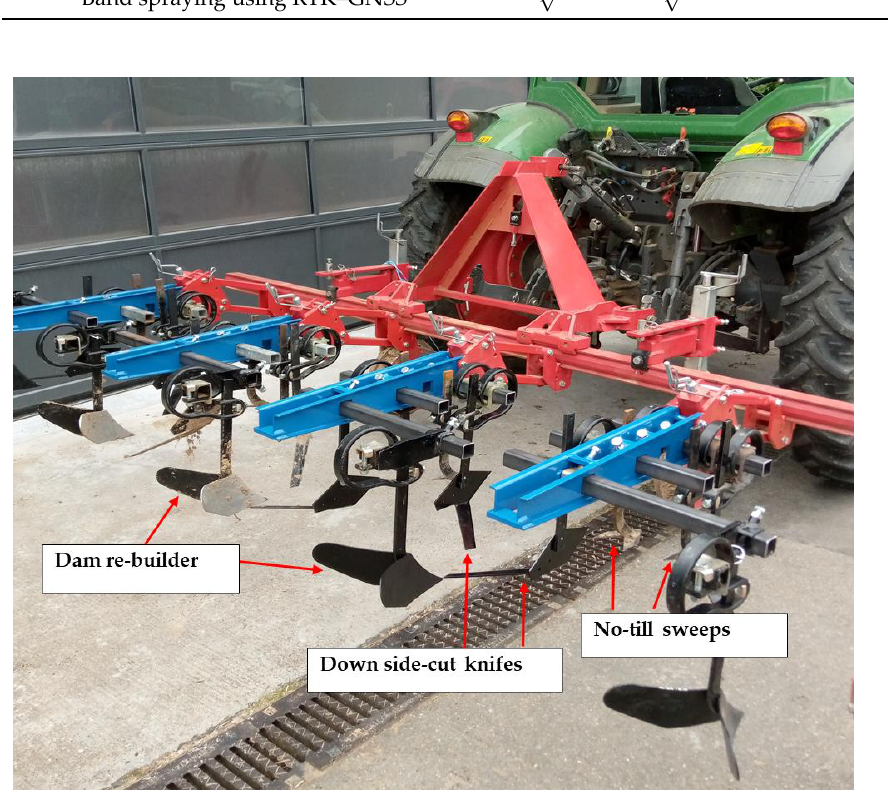
Figure 2. RTK–GPS-controlled hoe for mechanical weeding in a ridge tillage system. No-till sweeps cut weeds next to the crop row on the top of the ridge, down side-cut knives remove weeds in the slopes of the ridge and ridge-re-builders are used before sowing living mulch in the furrows. Photo: O. Alagbo.